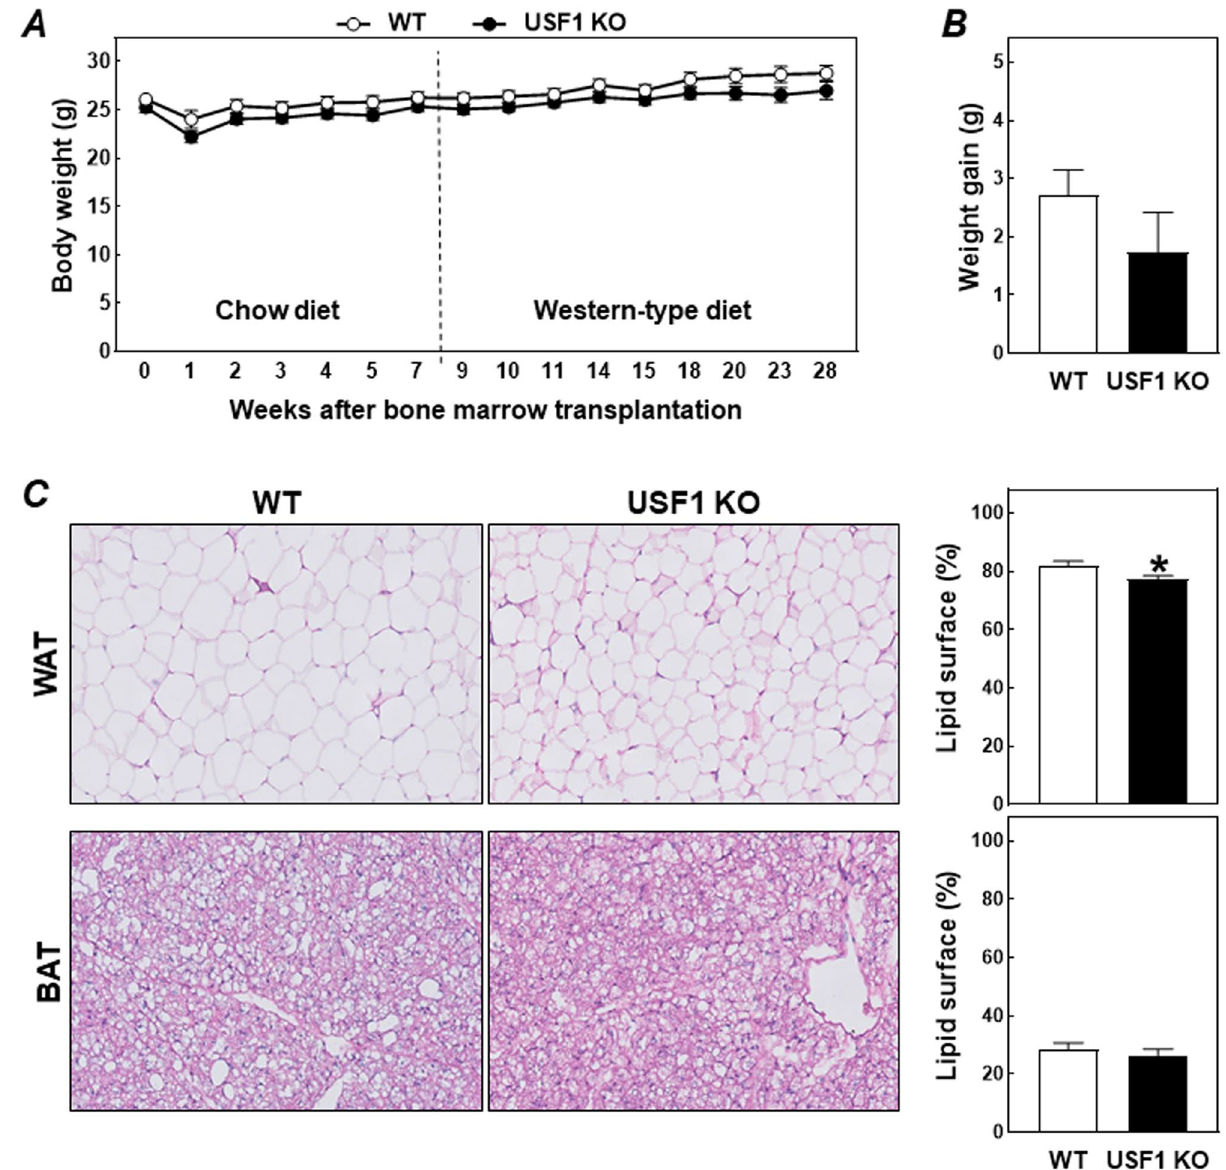
Figure 1. Body weight development ( A ) and total body weight gain ( B ) in LDL receptor knockout mice transplanted with bone marrow from USF1 knockout (USF1 KO) mice or their wild-type (WT) littermate controls. ( C ) Representative images of hematoxylin and eosin-stained sections of BAT and WAT from the two types of bone marrow recipients (left) and quantification of the relative lipid droplet surface areas (right). Data represent the means ± SEM of respectively 11 WT and 16 USF1 KO bone marrow recipients. * P < 0.05 versus marked increase was detected through flow cytometry in the percentage of Nile Red high leukocytes in the blood of USF1 knockout bone marrow recipients as compared to wild-type bone marrow recipients (+ 100%; P < 0.01) (Fig. 4A). Parallel routine hematological analysis showed no change in absolute blood lymphocyte counts in LDL receptor knockout mice transplanted with USF1 knockout bone marrow (Fig. 4B). The increase in leukocyte lipid levels, however, did coincide with a significant rise in the blood neutrophil count (+ 64%; P < 0.01; Fig. 4B) and a trend towards an increase in circulating monocyte numbers (+ 35%; P = 0.10; Fig. 4B). Flow cytometric analysis further verified that the marked increase in absolute neutrophil counts in USF1 knockout bone marrow recipients translated into a shift in the relative blood leukocyte distribution pattern. The blood leukocyte population from USF1 knockout bone marrow recipients contained relatively lower numbers of CD4 + helper and CD8 + cytotoxic T cells and CD19 + B cells in the context of a significantly higher CD11b + Ly6G + neutrophil fraction (Fig. 4C). Rela- tive CD11b + Ly6C + monocyte counts were not different between the two groups of mice (Fig. 4C). However, bone marrow USF1 deficiency was associated with a monocyte phenotype shift towards the pro-inflammatory mono- cyte fraction expressing the cell surface marker Ly6C at an intermediate level (Ly6C int ; + 52%; P < 0.01; Fig. 4D).